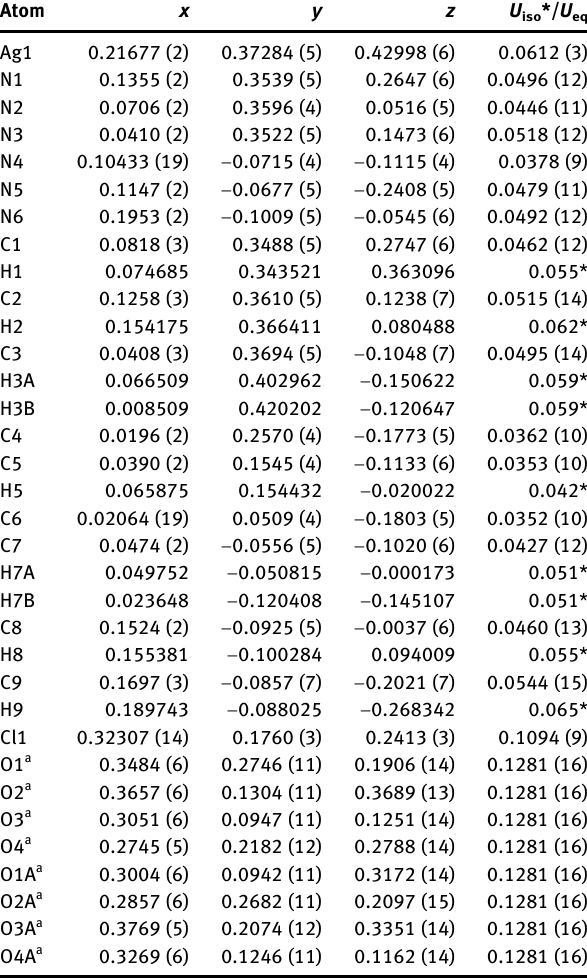
center is coordinated by two nitrogen atoms from two L ligands, showing an approximately linear coordination environment. The N – Ag – N bond angles are all 167.18 ° . The